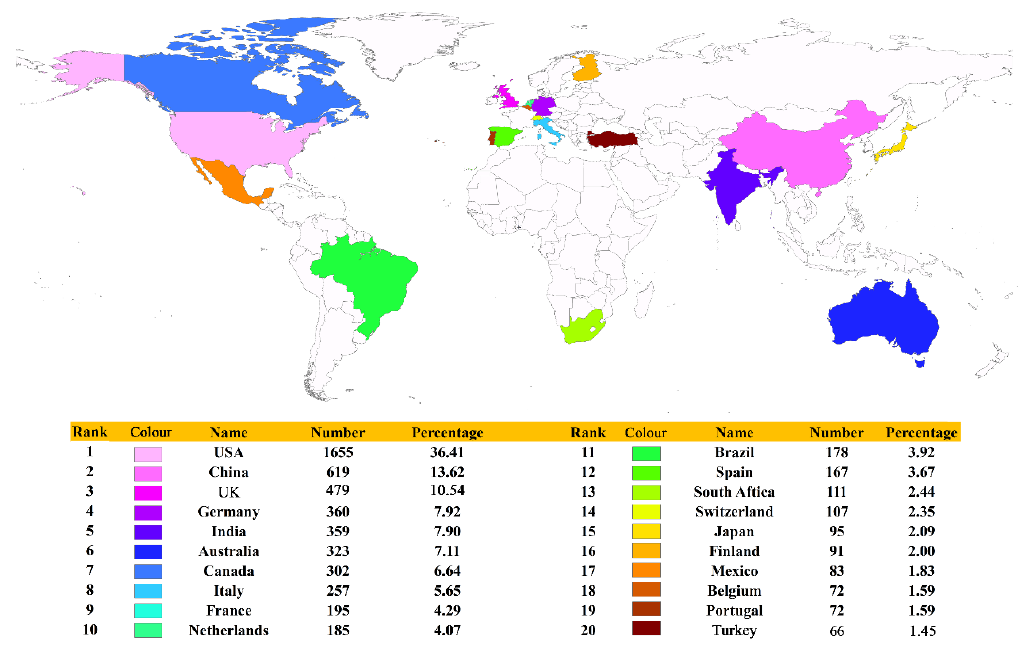
Remote Sens. 2020 , 12 , 772 Figure 3. The geographic distribution of the top 20 productive countries. Figure 3. The geographic distribution of the top 20 productive countries.